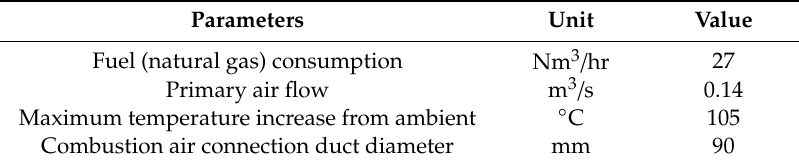
Table 1. Design parameters for a combustion air resistance heater.